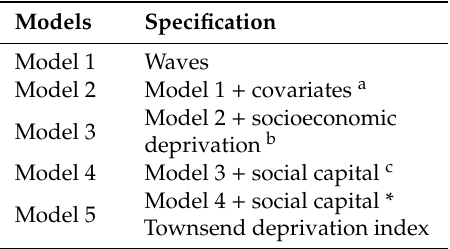
Table 2. Summary of multilevel regression models examined in this